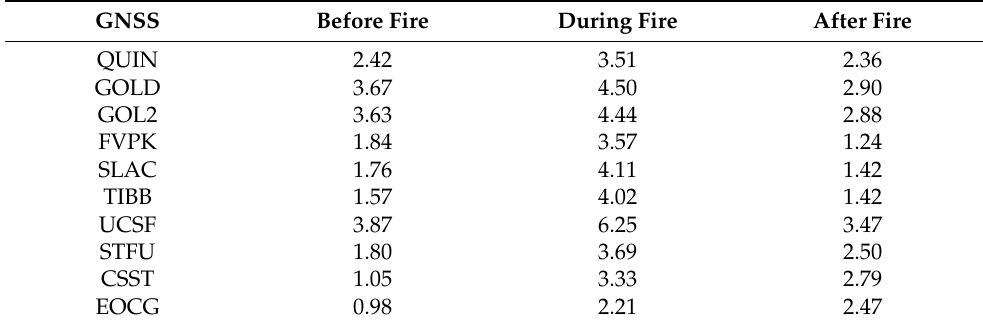
Table 5. Statistics of mean of the difference ( ∆ PWV) between the PWV of virtual radiosonde stations network and GNSS-derived LPWV in different fire periods (mm). GNSS Before Fire During Fire After Fire QUIN